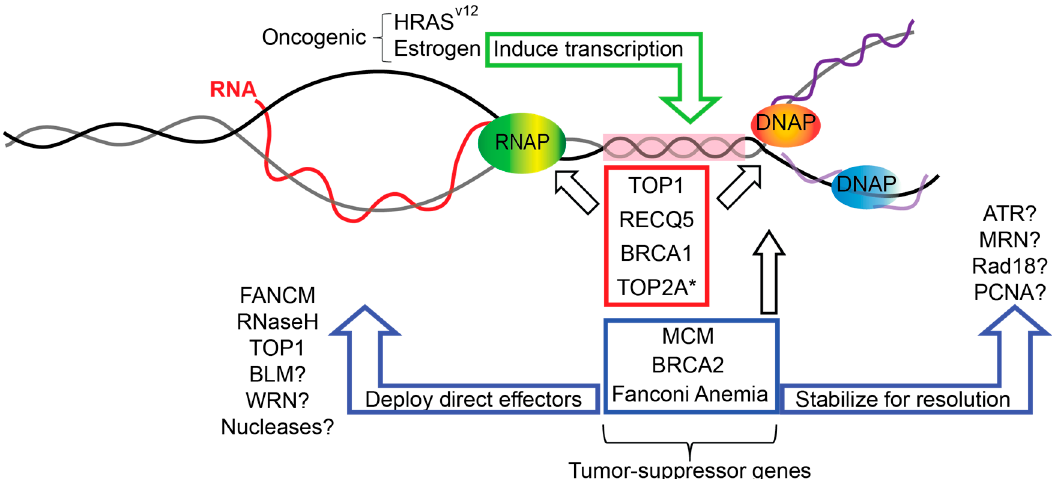
Figure 1. DNA replication fork protection factors mitigating transcription–replication conflicts. A nascent RNA (red) emerging from RNA polymerase (RNAP) annealed to its template could impede an incoming DNA replication fork (orange and blue polymerases (DNAP), right) to create a region of topological conflict (pink box, a replication–transcription collision). Fork protection factors with dual roles in transcription and replication (red box) or with roles at replication forks only (blue box) could act to suppress such conflicts either directly, as is the case for Fanconi anemia complementation group M (FANCM), RNaseH, and topoisomerase I (TOP1), or could act indirectly by stabilizing replication forks to allow time for canonical R-loop resolution mechanisms to act. Tumor suppressor gene mutations impact these fork protection mechanisms. Oncogenic mutations or stimuli also contribute to transcription-replication conflicts by inducing or creating aberrant transcriptional programs. * TOP2A was implicated indirectly in the cited study showing that p53 mutations increase transcription ‐ replication conflicts [57].